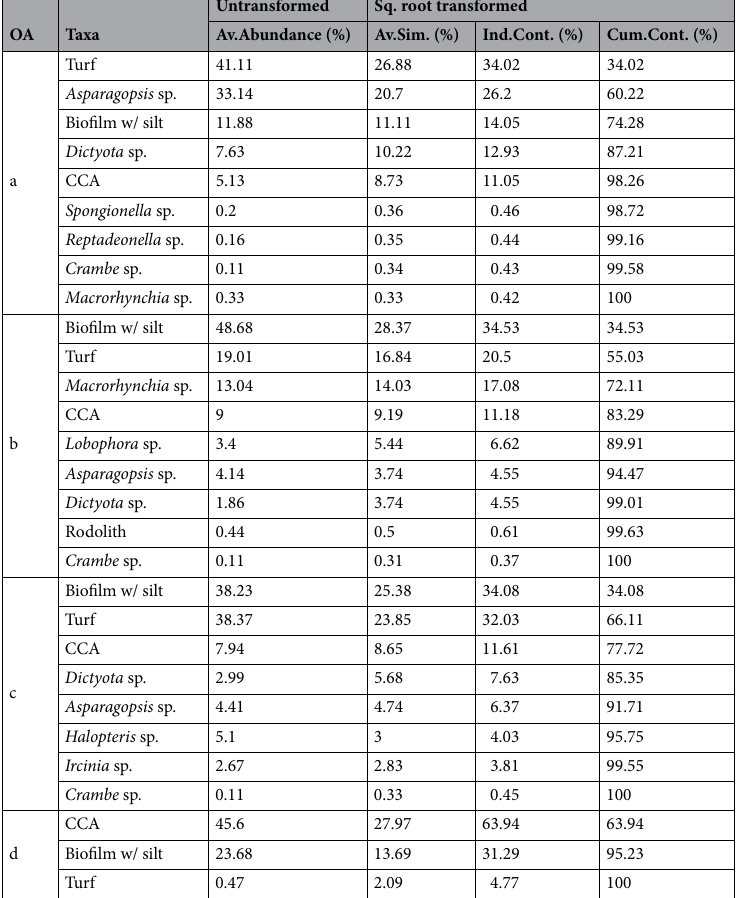
Table 1. Taxa composition and contribution to SIMPROF generated organism assemblages (OA) present at 3–6 m and 9–11 m depth over rocky bottom: Average Abundance (Av. Abundance) based on Untransformed data; Average Similarity (Av. Sim.) and Individual (Ind. Cont.) and Cumulative (Cum. Cont.) Taxa Contribution (%), based on Square rooted transformed data.